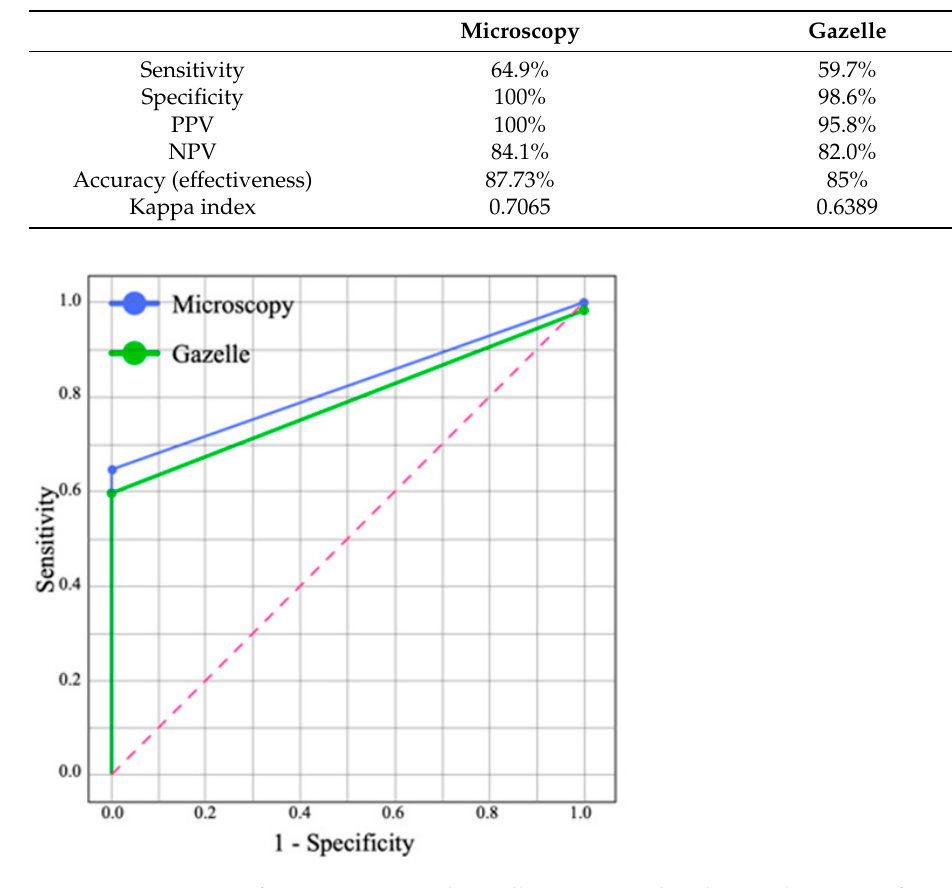
Table 4. Microscopy and Gazelle™ performance values in relation to the reference method (nested PCR).